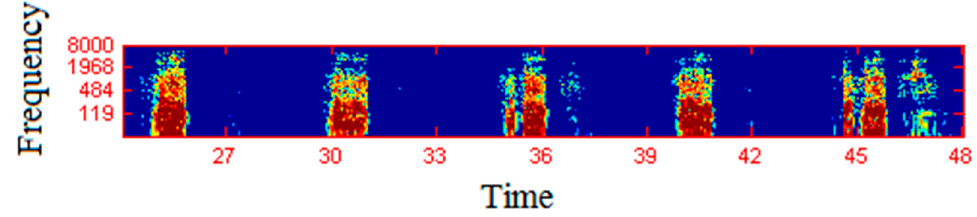
Figure 5. Spectrogram of the snoring sound.